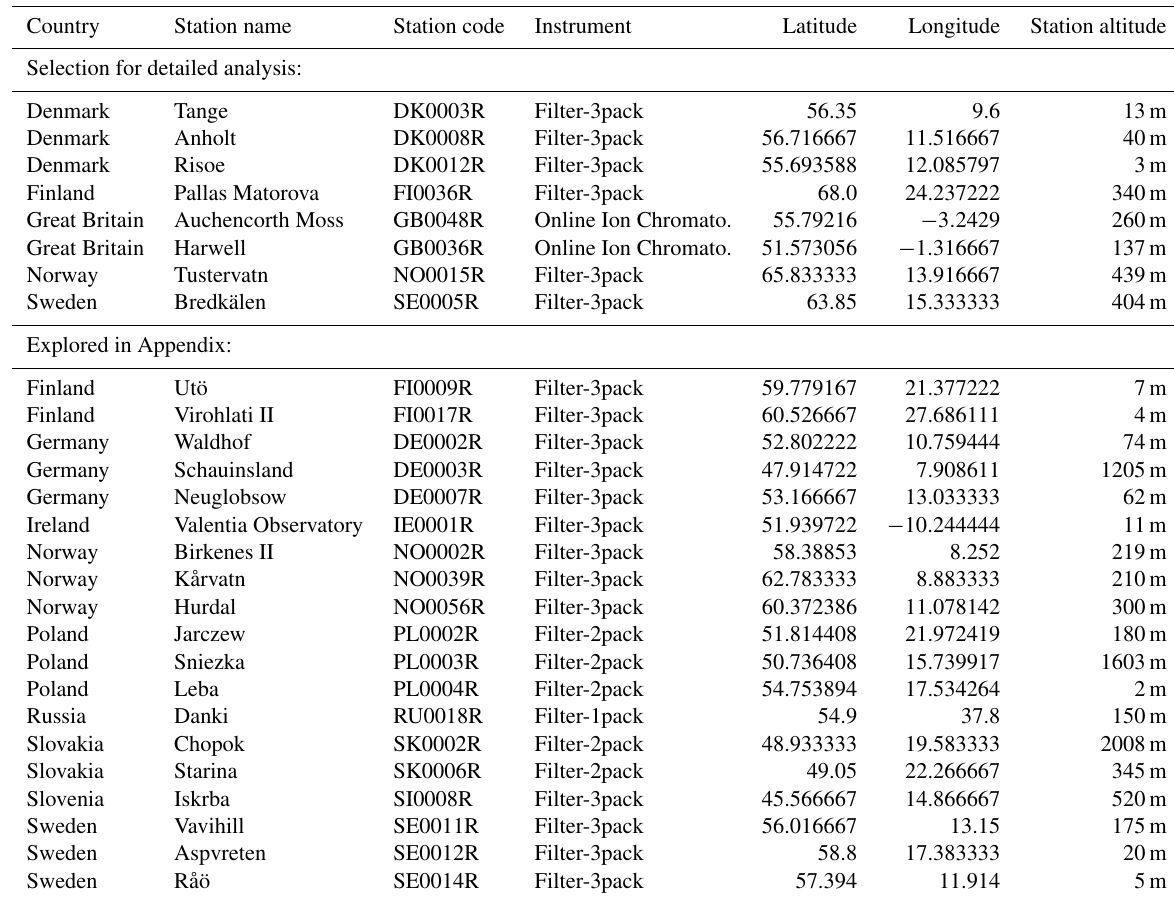
Table 1. Details of the 27 EMEP stations explored in this study and shown on the map of Fig. 13.